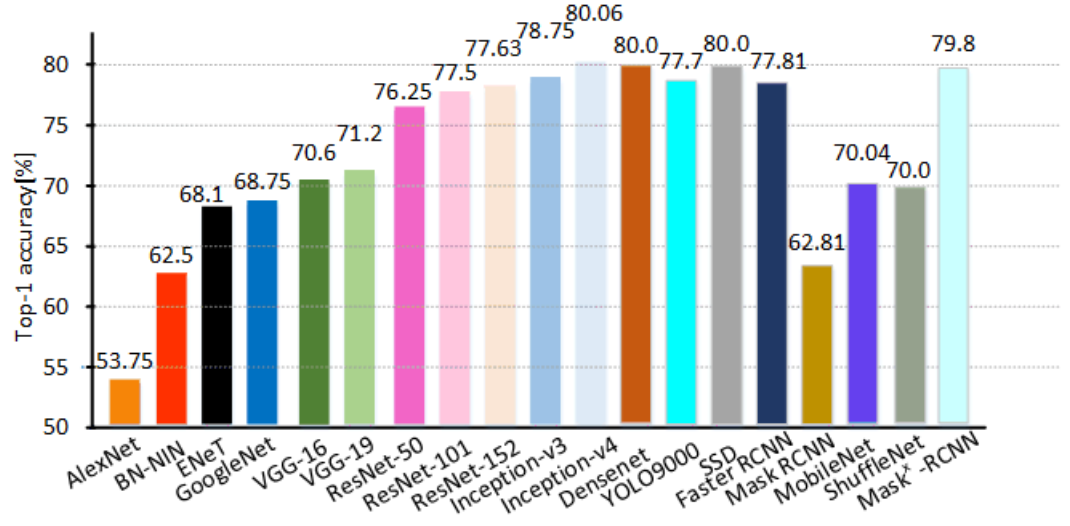
Figure 10. Single-crop top-1 validation accuracies for top scoring single-model